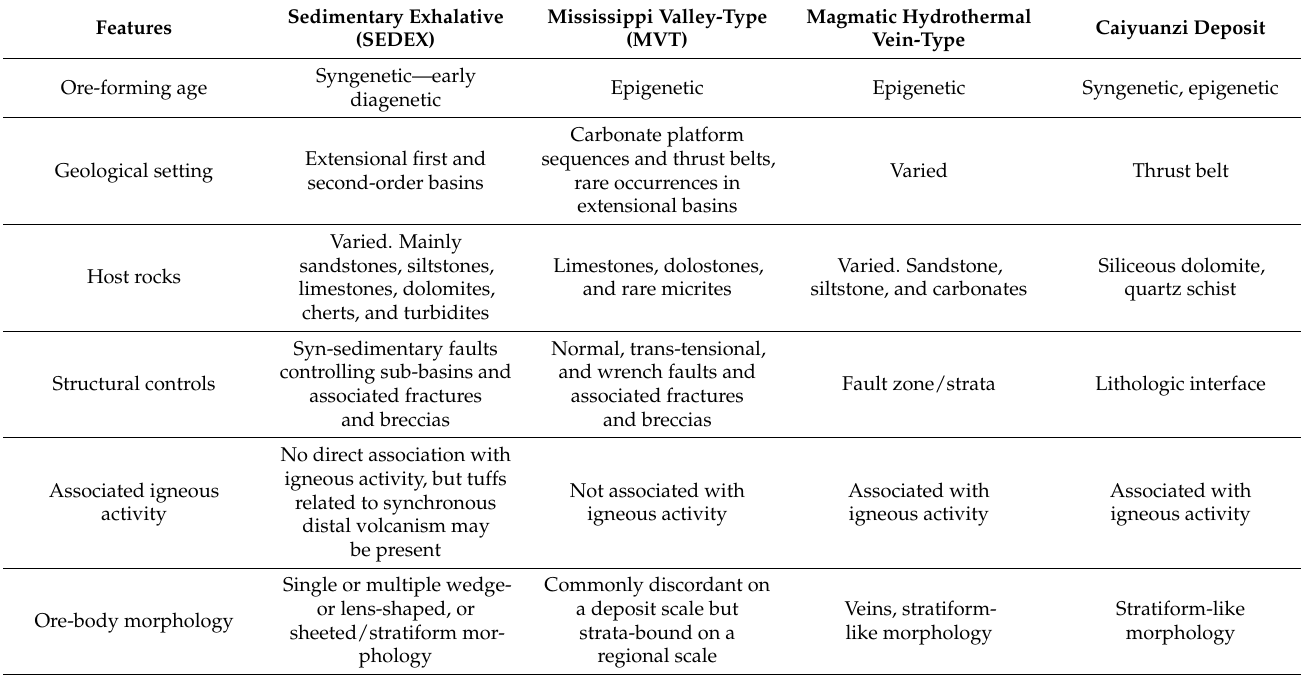
Table 4. Summary and comparison of principal characteristics of SEDEX, MVT, magmatic hydrother- mal vein-type, and the Caiyuanzi Pb–Zn